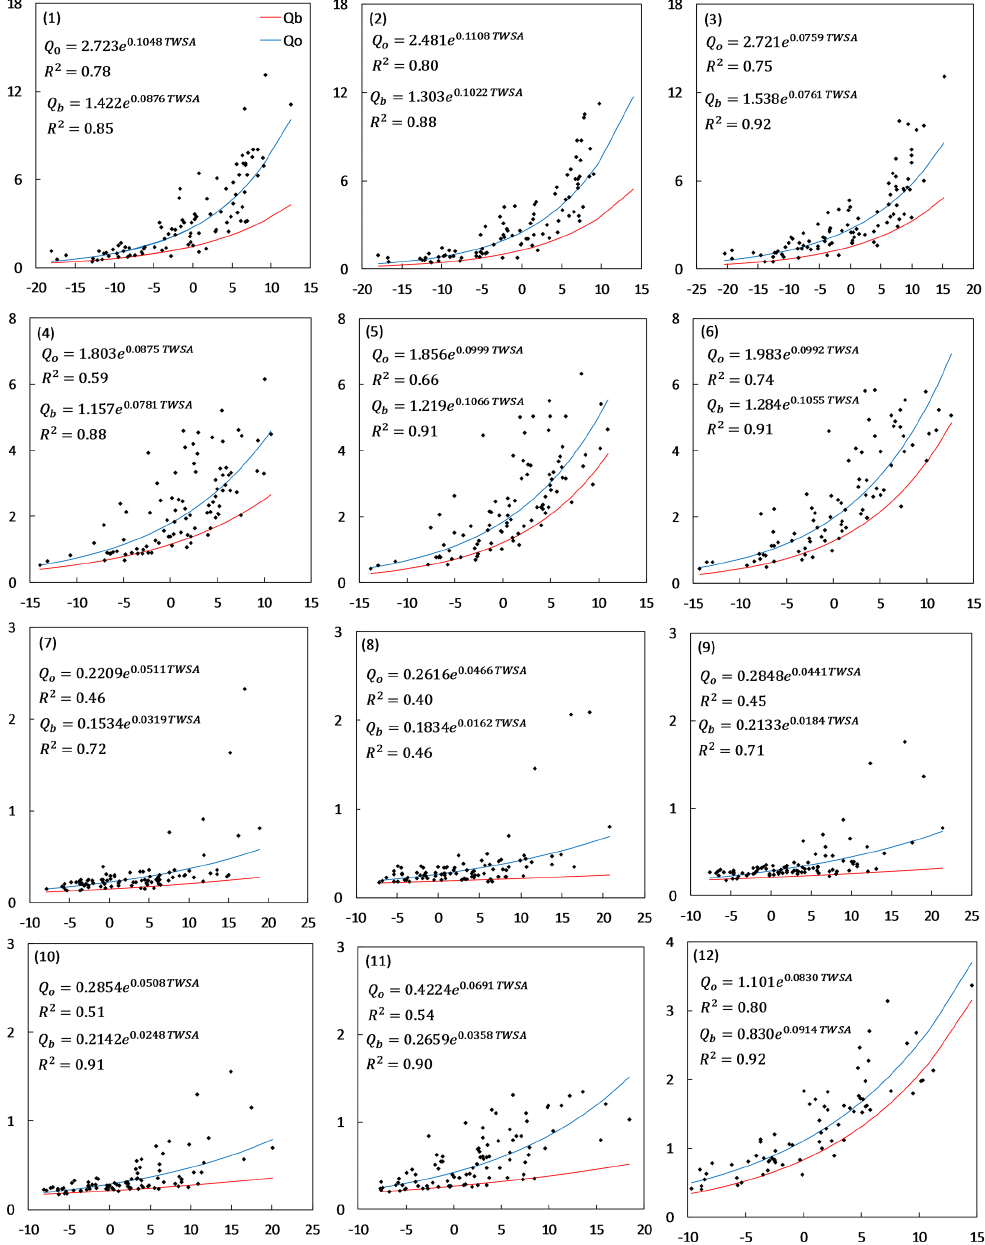
Figure 3. Non-winter (April–October) monthly observed discharge ( Q o , y axis, in cm) and storage ( S , x axis, in cm represented by TWSAs); the lines represent the relationship between observed discharge (blue) or baseflow (red) and storage. The plot IDs correspond to the site IDs listed Table 1 and shown in Fig. 1. All relationships are significant at a 99% confidence interval ( p value < 0.00001), based on a t